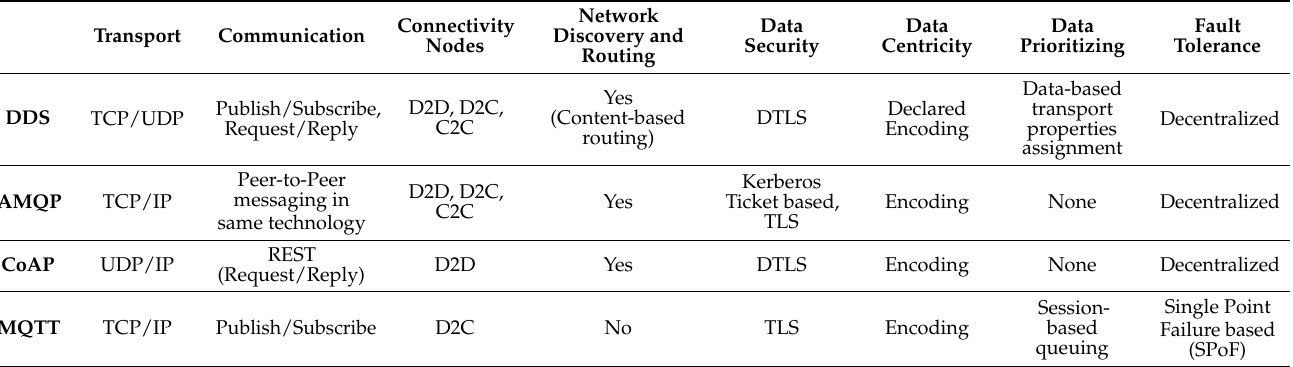
Table 8. Qualitative comparison of DDS-, AMQP-, CoAP-, and MQTT-based IoT